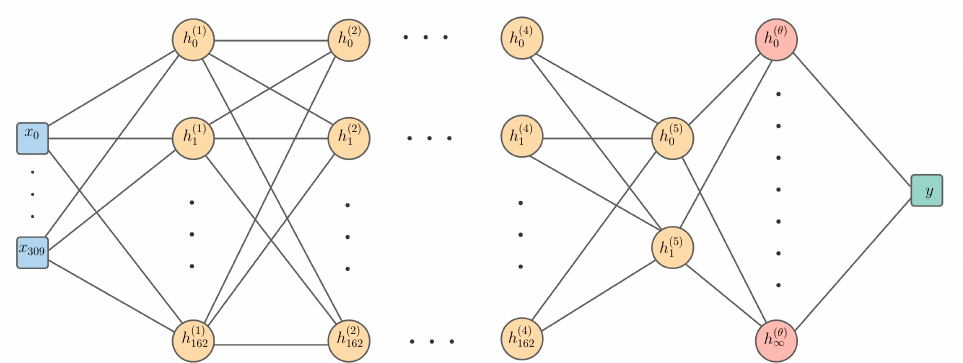
Figure 3. A Gaussian process with a deep kernel which maps the 310 input features x through five parametric hidden layers followed by a single hidden layer with an infinite number of basis functions using the RBF base kernel. The kernel’s hyperparameters are denoted as θ , whereas those of the parametric layers are denoted as w . Each of the first four parametric hidden layers has 163 units, while the final parametric hidden layer has two units. There is only one unit in the output y , representing a single value for log EC 50